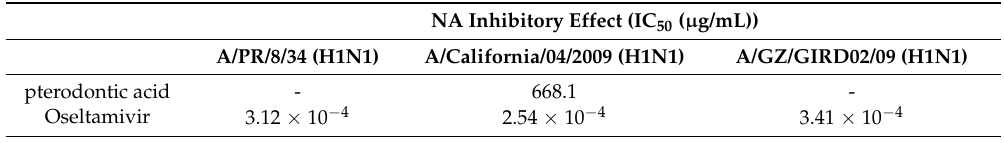
Table 2. Inhibition of pterodontic acid on NAs from Influenza A viruses